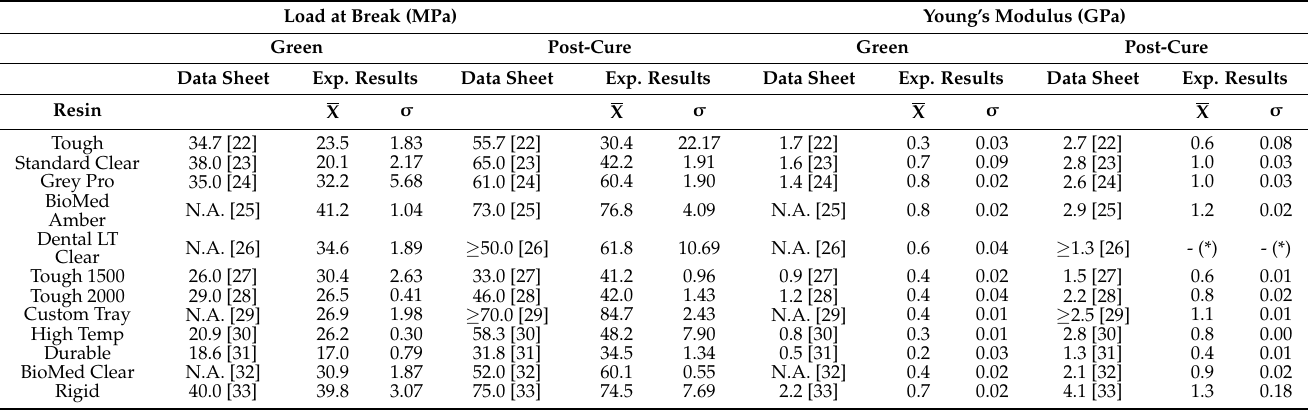
Table 2. Load at break and Young’s modulus values as obtained for each resin. Comparison between green and post-cure conditions. Mean X and standard deviation values σ